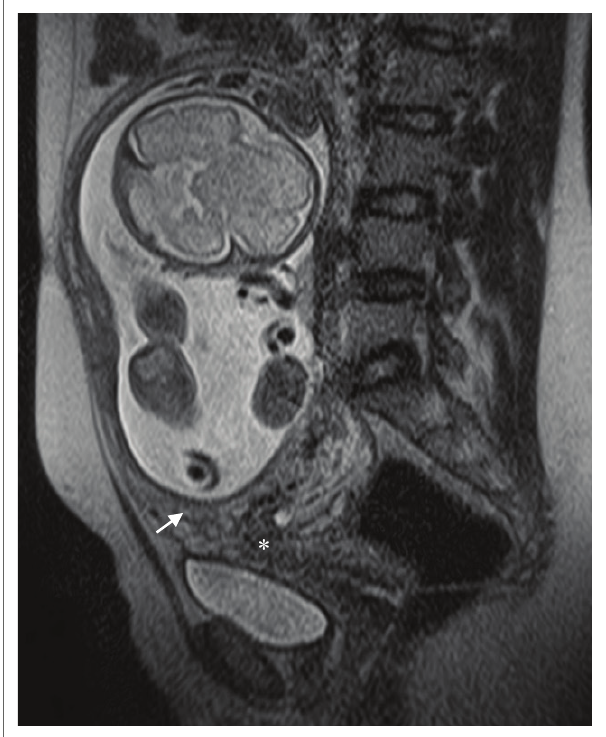
FIGURE 4: Sagittal T2-weighted magnetic resonance imaging demonstrating low- lying placental tissue (white arrow), separate from the main bulk of the placenta, with complete coverage of the internal ostium (os) of the cervix